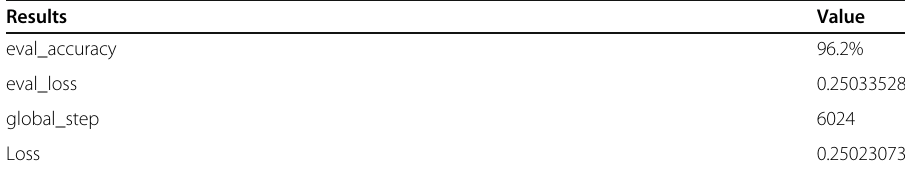
Table 2 Text information classification results of sellers on social